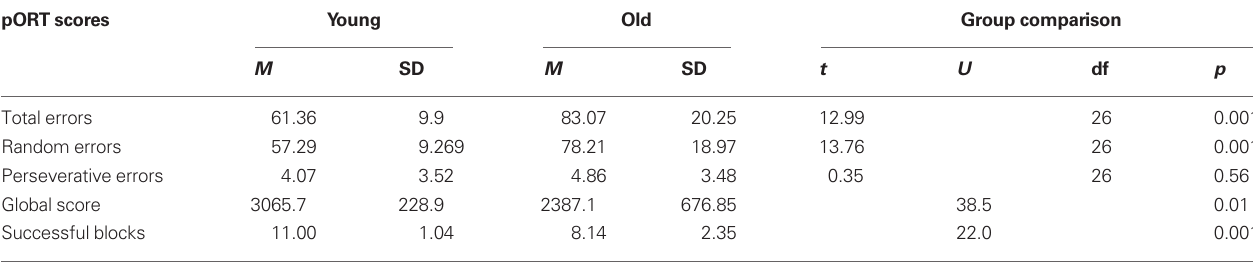
Table 3 | Effect of age on the probabilistic Object Reversal Task (pORT). Behavioral data for younger and older participants.